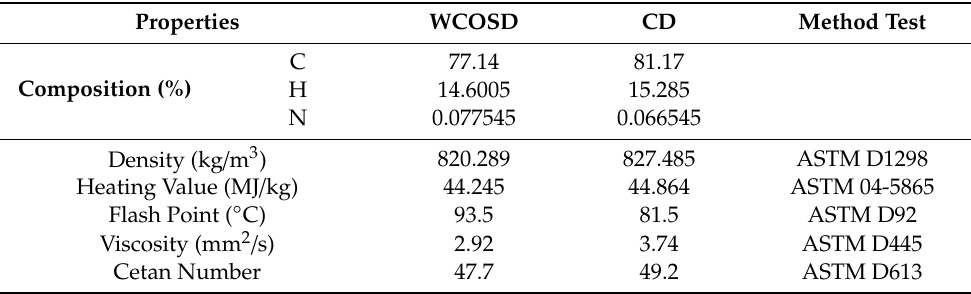
Table 2. Chemical and physical properties of tested